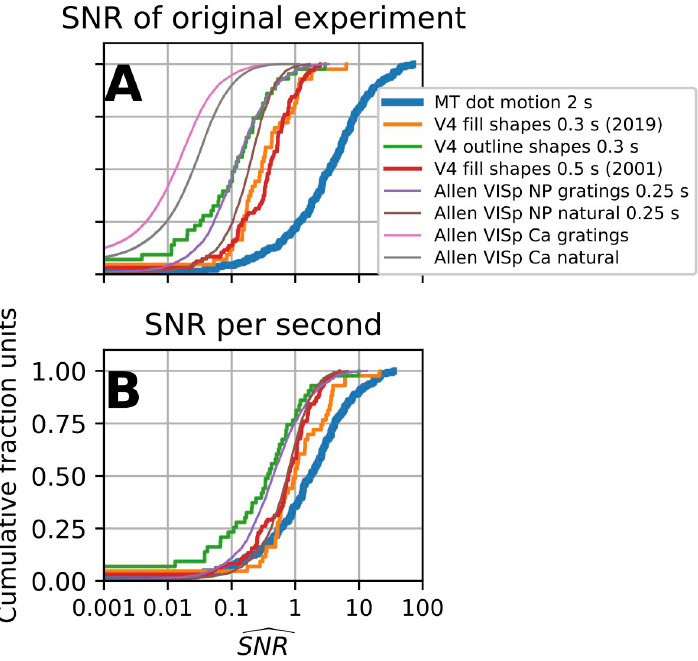
Fig 12. A comparison of our data quality metric, the signal-to-noise ratio estimator d SNR (Eq 16), across several datasets. (A) The cumulative distribution of d SNR under the original experimental protocols. Traces with the same line thickness have similar numbers of n and m . Thick line (blue): MT data has n � 10, m = 8. Medium lines (green, orange, red): V4 data has n � 5, m � 350. Thin lines: Allen Inst. data has n � 50, m � 120. The Allen Inst. data has two recording modalities: extracellular action potentials (spikes) on Neuropixel probes (NP) and two-photon calcium imaging (Ca). Both were recorded for the same stimuli: natural scenes and gratings (see Methods, “Electrophysiological data”). (B) Distribution of d SNR after normalization with respect to the duration of the spike counting window (traces for calcium signal are not included). The normalization assumes that the original average spike rate can be applied to a 1 s counting window. But, if firing rates tend to decay over time, this will produce overestimates for recordings shorter than 1 s and underestimates for recordings longer than 1 s.